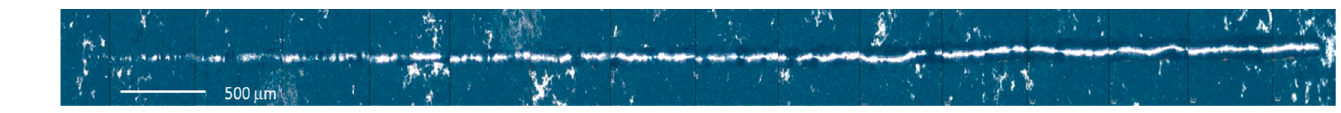
Figure 3. Scratch track of WC-Ni coatings.